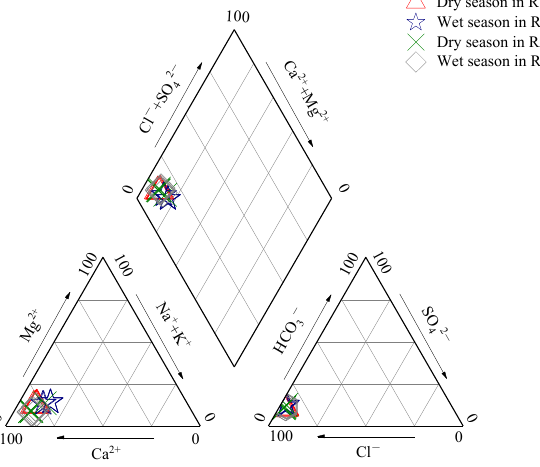
Figure 3. Piper chart of river water in the study area (ion equivalent concentration).